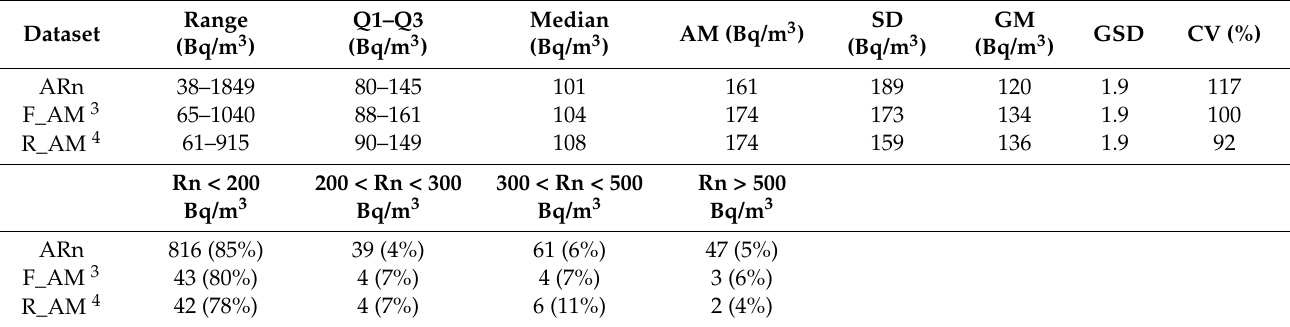
Table 2. Descriptive statistics 1 of annual radon activity concentrations (top) and number of exceedances 2 for fixed levels of annual radon activity concentrations (bottom) estimated in 963 rooms belonging to 54 buildings.